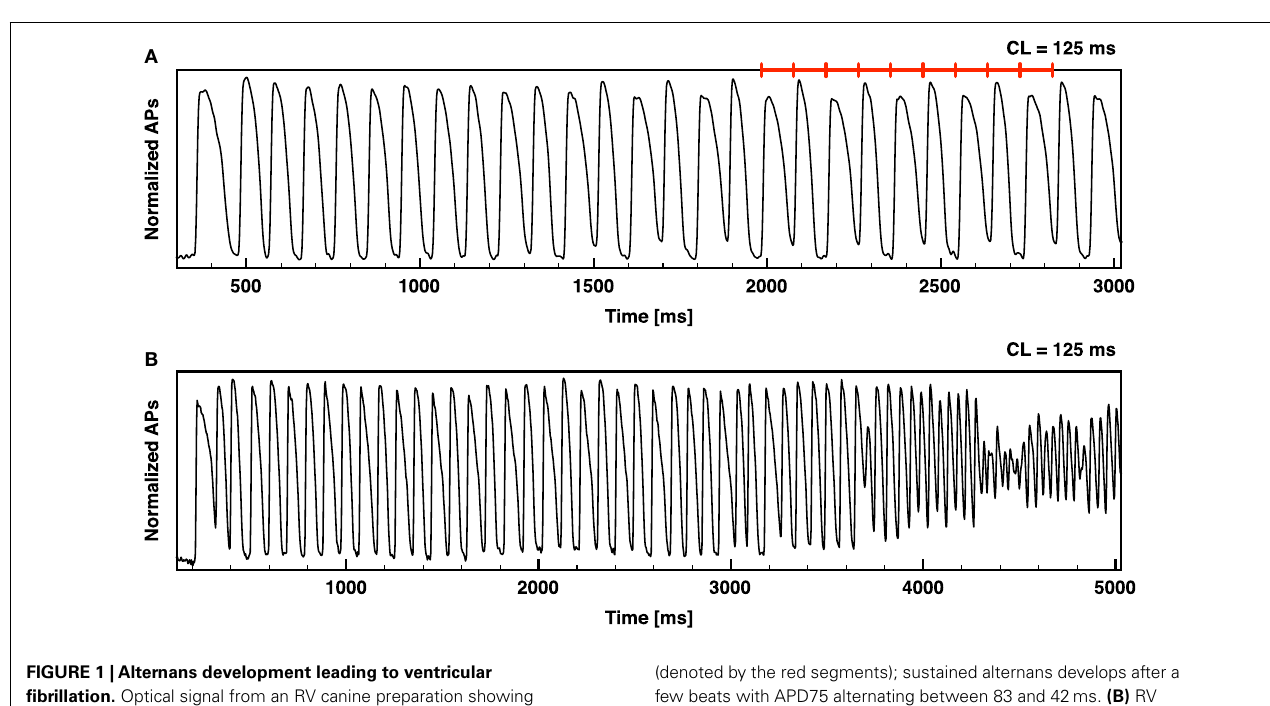
FIGURE 1 |Alternans development leading to ventricular fibrillation. Optical signal from an RV canine preparation showing alternans development and alternans leading to ventricular fibrillation (VF). (A) RV paced from rest at a constant CL of 125ms